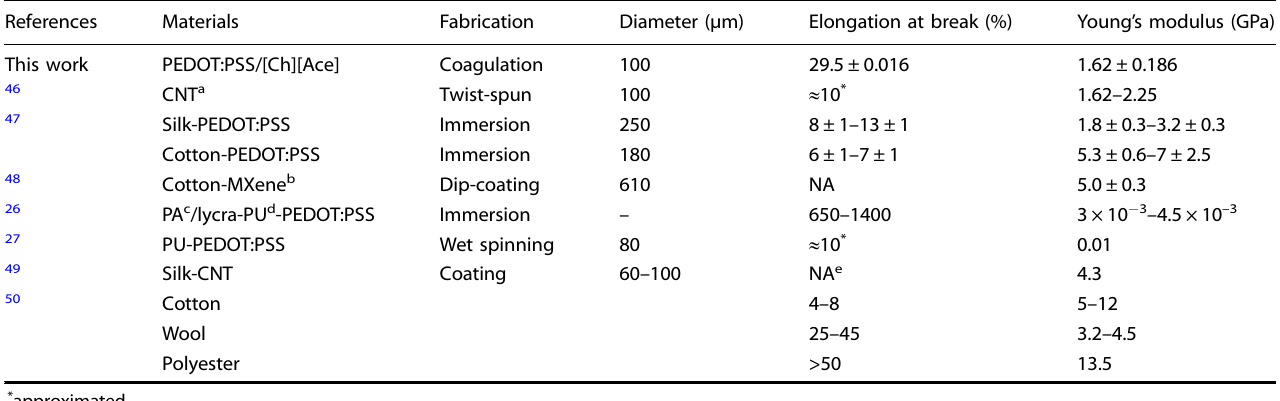
Table 1. Parameters of conductive fi ber and commercial materials for fi